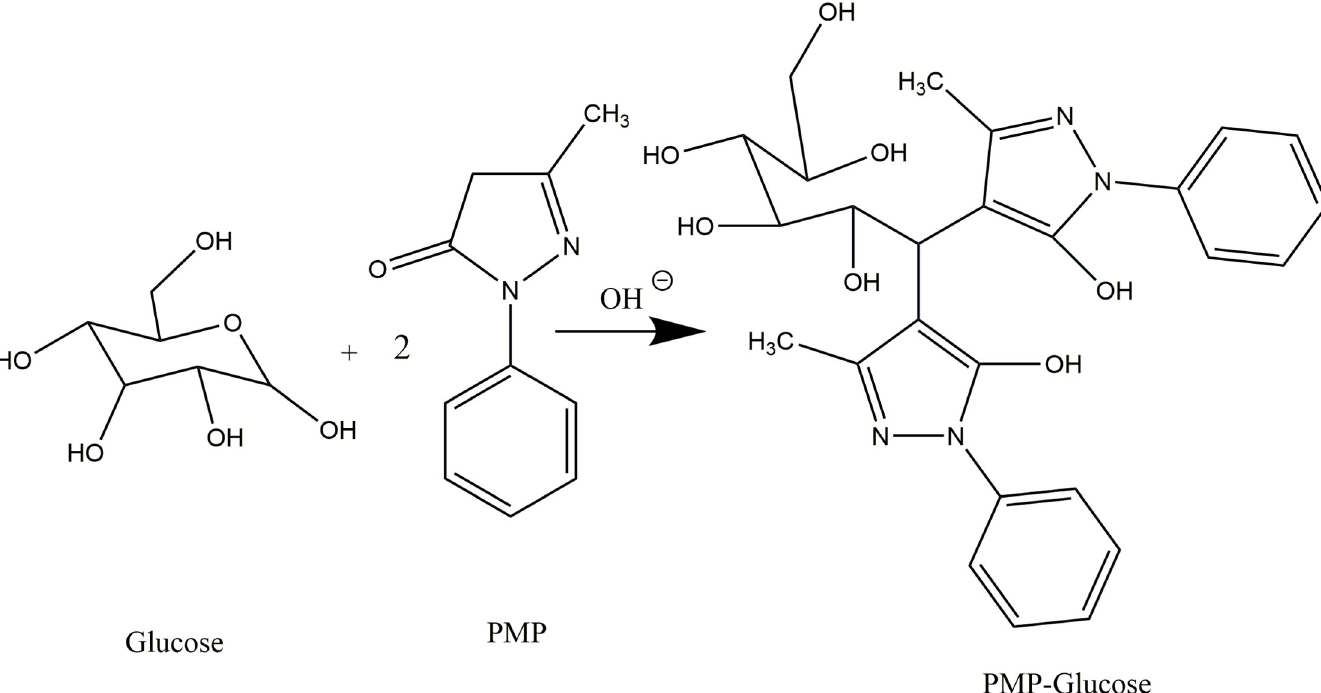
Fig 1. A reaction scheme for the formation of PMP-Glucose. One equivalent of glucose reacts with two equivalents of PMP to form one equivalent of PMP-Glucose under basic conditions.